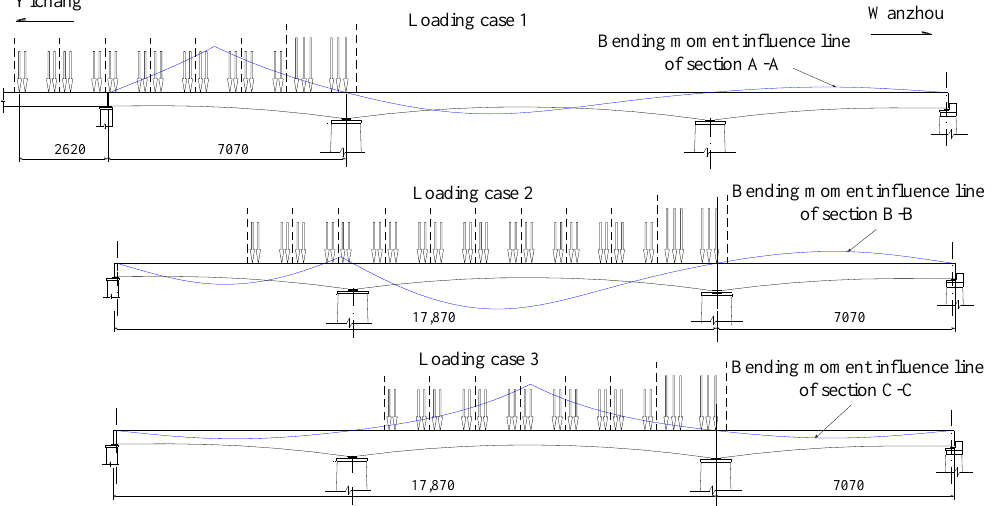
Figure 3. Loading cases of static tests (unit: cm).